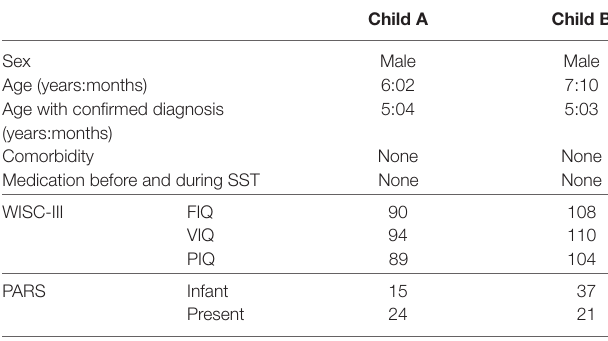
taBlE 1 | Profiles of participants with